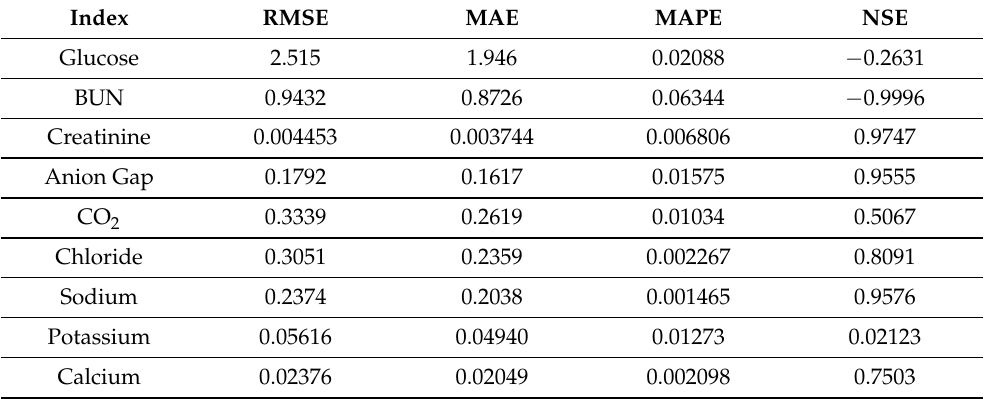
Table A3. Errors in other metrics of the one-step prediction of the original patient.